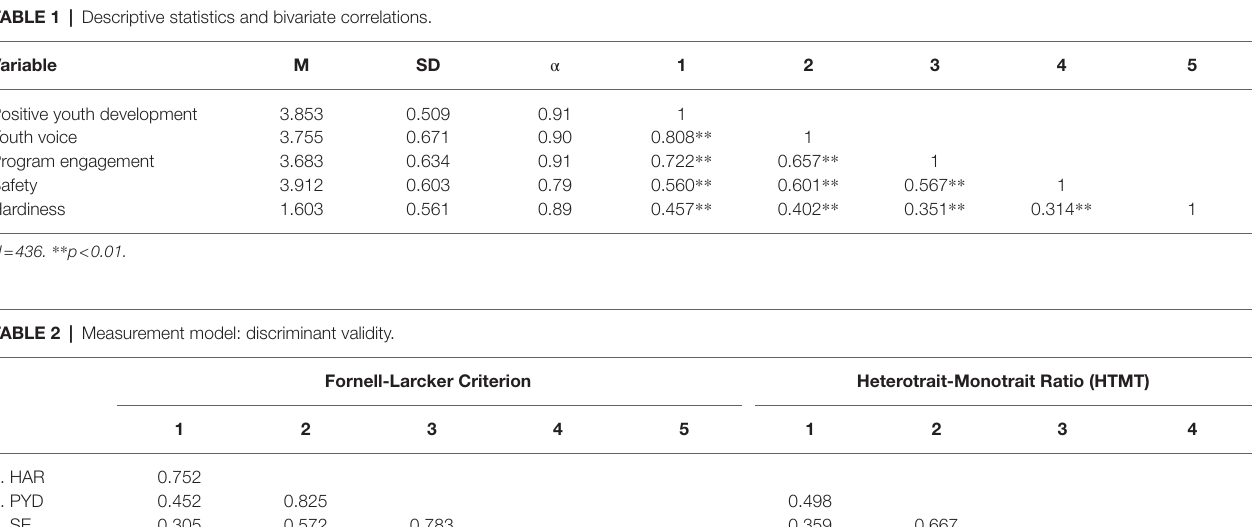
Fornell-Larcker